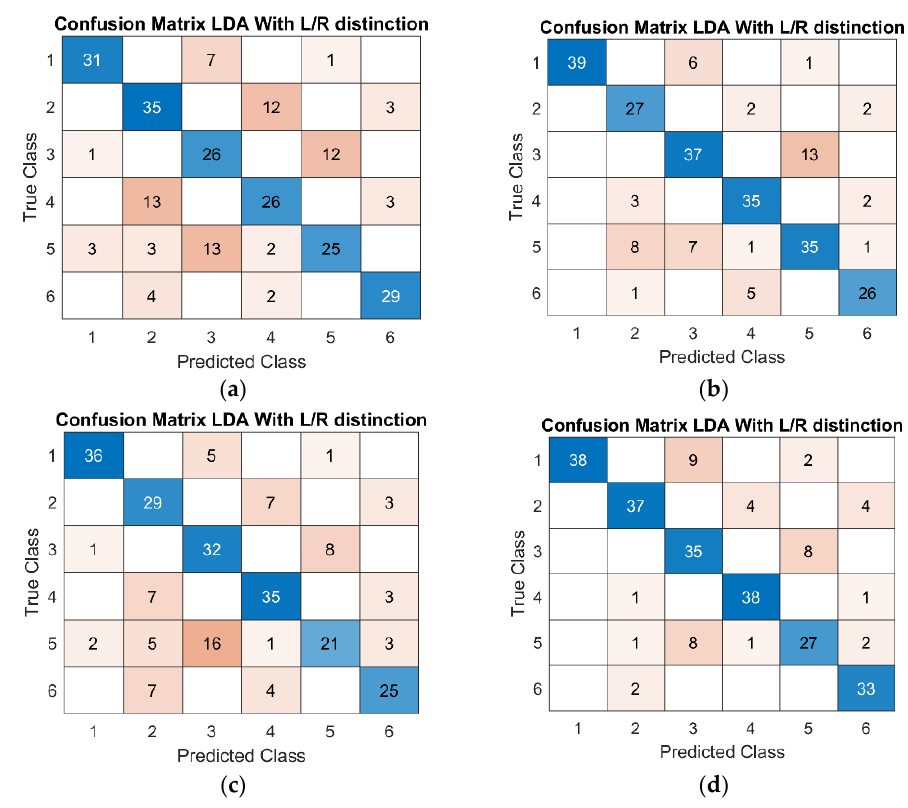
Figure 7. Example of LDA confusion matrixes with left and right limb distinction for ( a ) HD2, ( b ) HD4, ( c ) HD6, and ( d ) HD8. Testing dataset is 15% of the original data.